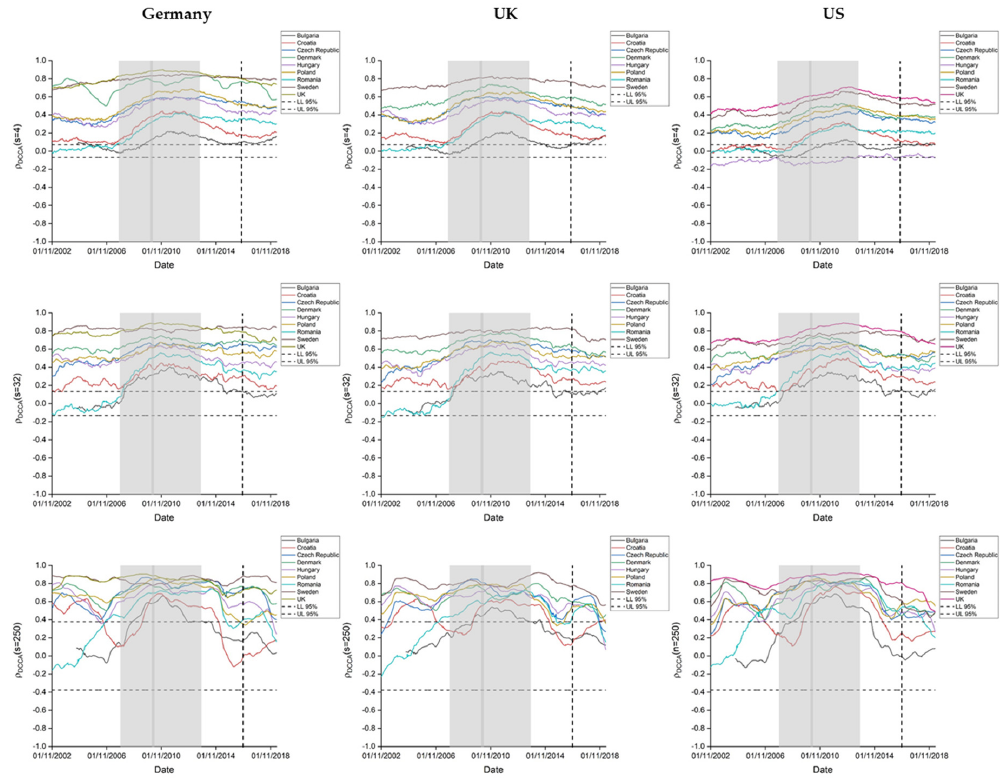
Figure 4. Evolution of ρ DCCA between non-Eurozone stock markets and Germany ( left panel ), the UK ( middle panel ), and the US ( right panel ) (time scales of 4, 32, and 250 days and window size w = 1000). LL and UL are, respectively, the lower and upper limits of the confidence interval. Shaded areas represent the global financial crisis and the Eurozone debt crisis. The vertical dashed line refers to the moment of the Brexit referendum.